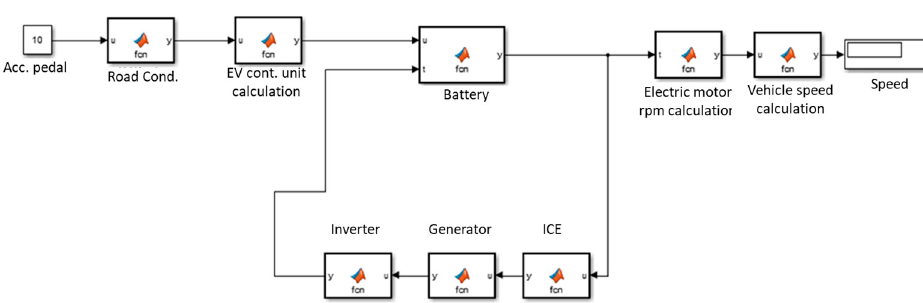
Figure 11. Basic Simulink model of REX.